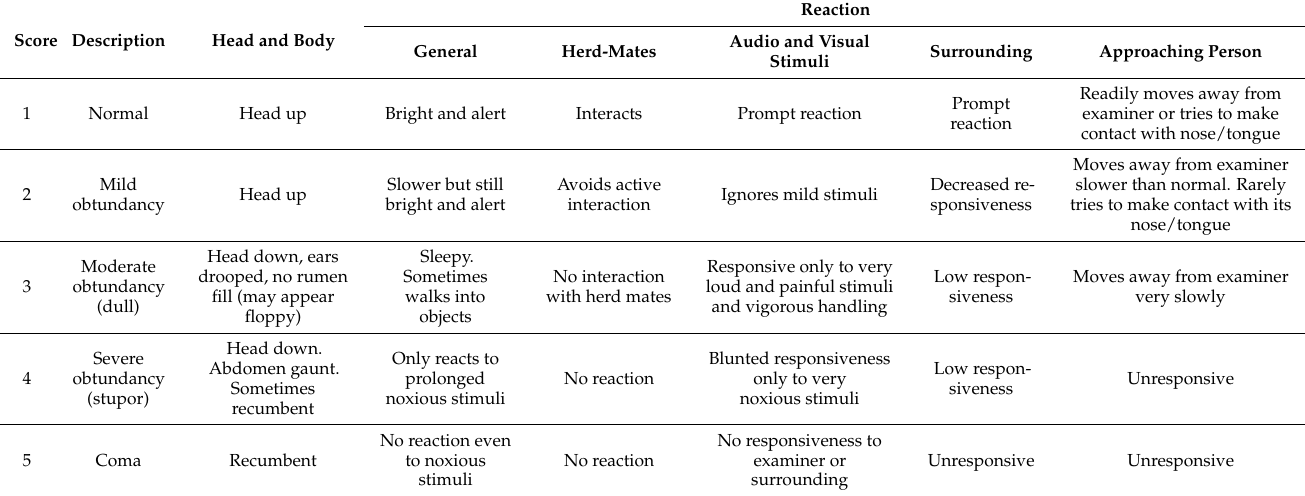
Table 1. Scoring of obtundancy in